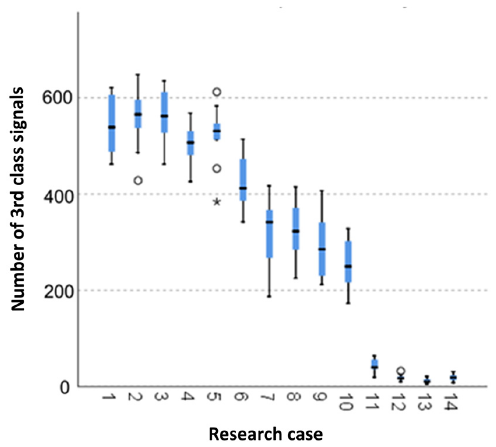
Figure 22. The graphical representation of the Kruskal–Wallis test results for independent tests of the number of the class 3 signals.